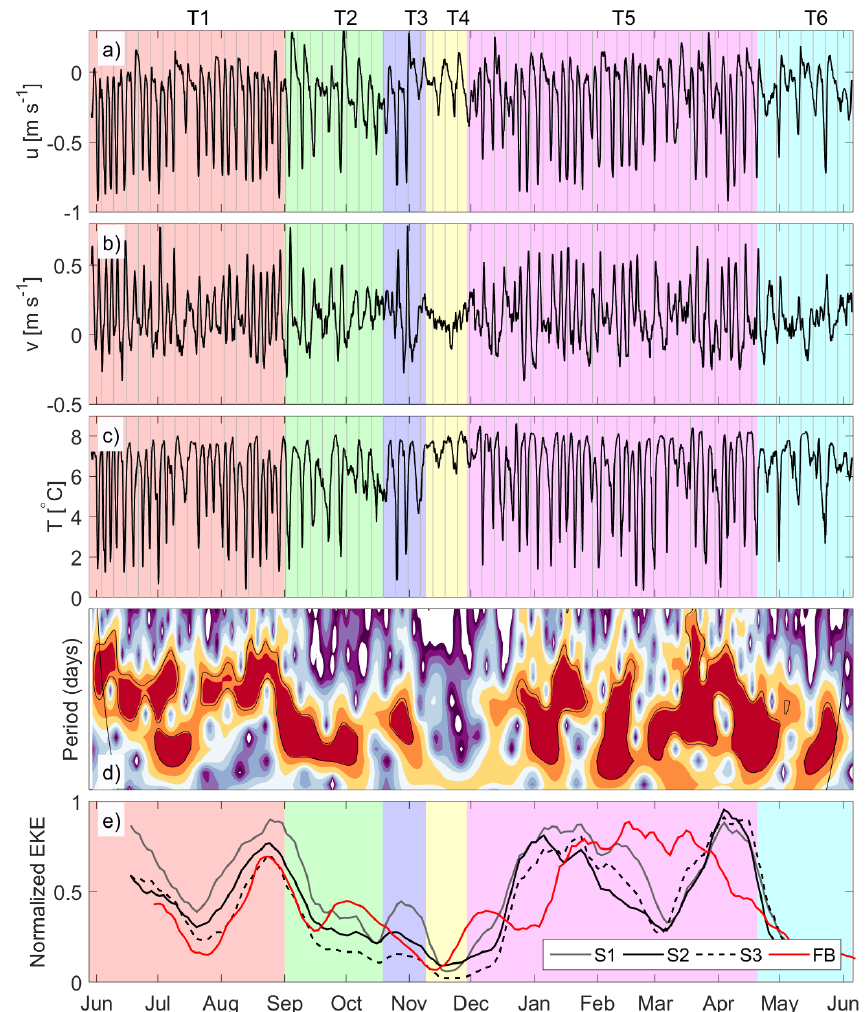
Figure 3. Time series from observations of (a) along-slope velocity, u , (b) across-slope velocity, v , and (c) temperature, T , measured at 80mab at mooring S1. Thin grey lines are inserted every sixth day and the background colour identifies the time intervals T 1 –T 6 marked in (a) and discussed in the text. (d) Results from wavelet analysis of along-slope velocity, measured at 600mab at mooring S3. Red colours indicate high energy levels and the black lines the 95% confidence levels. Results before and after the thin black lines at the start and end of the record are affected by edge effects. (e) Mean vertical EKE at moorings on the slope and the sill according to the legend. Values are normalized by the maximum value at each mooring.